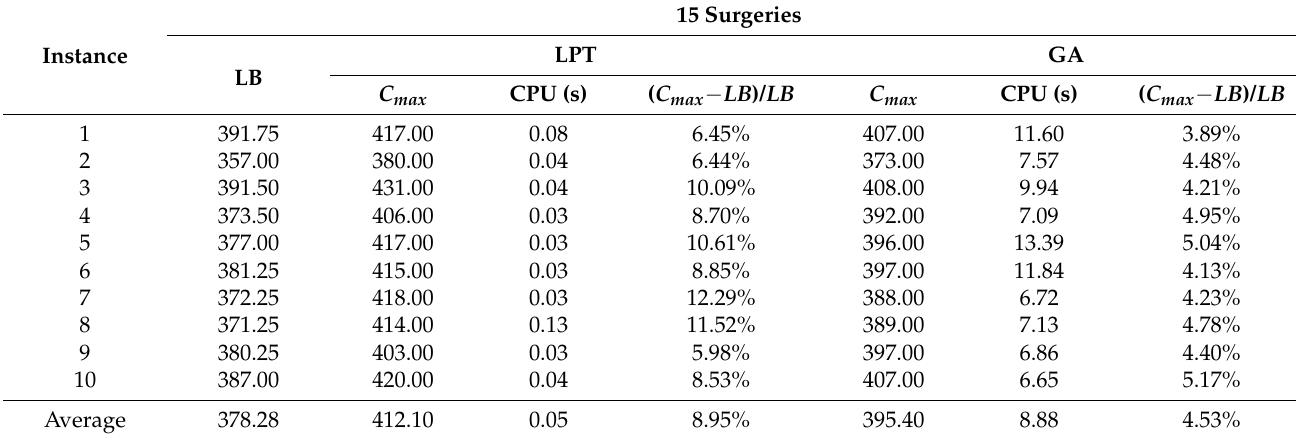
Table 6. Results of 15 surgeries.